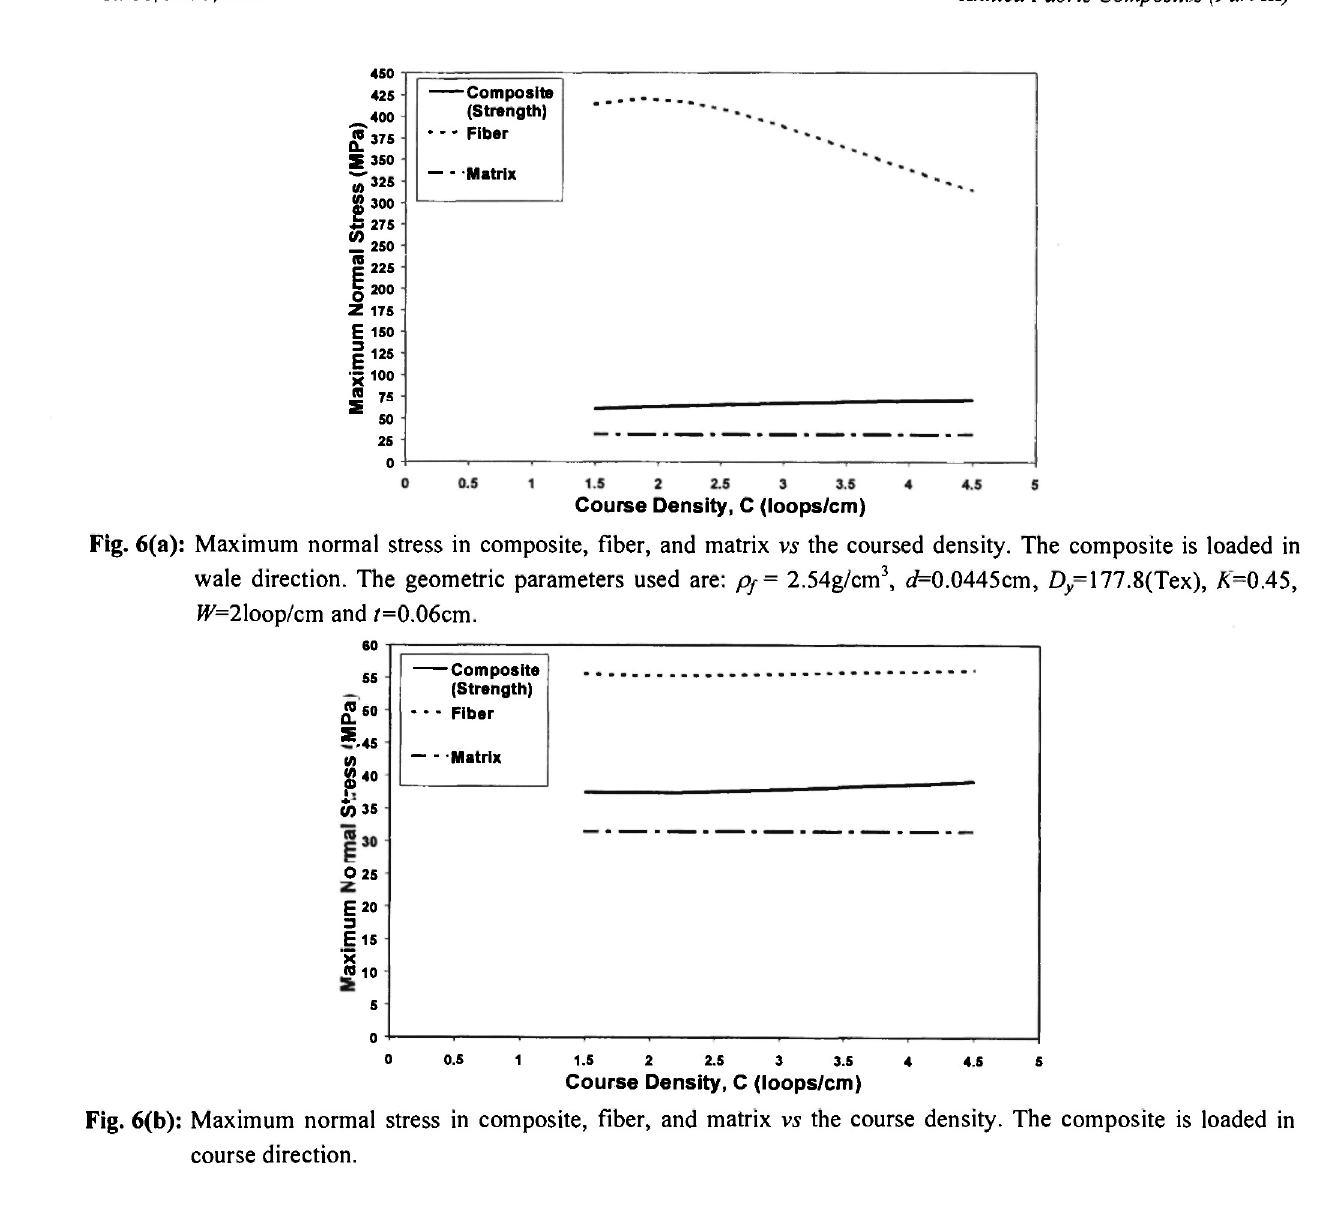
Fig. 6(b): Maximum normal stress in composite, fiber, and matrix vs the course density. The composite is loaded in course